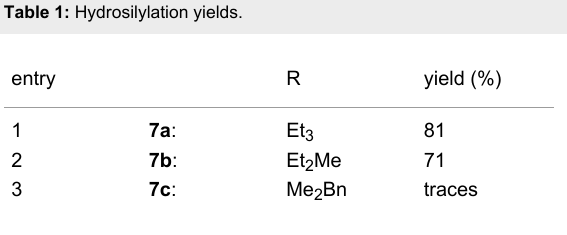
Table 1: Hydrosilylation